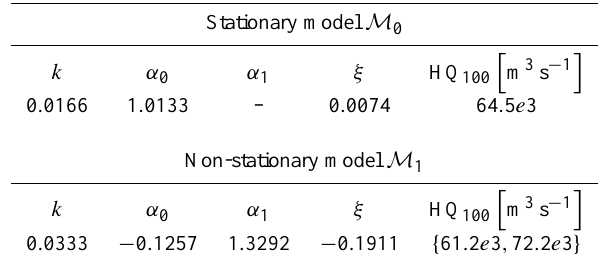
Table 2. Model parameters and estimated HQ 100 of the statistical test that rejected the stationary model M 0 . For M 1 , the range of HQ 100 values represents the variation between 1948 and